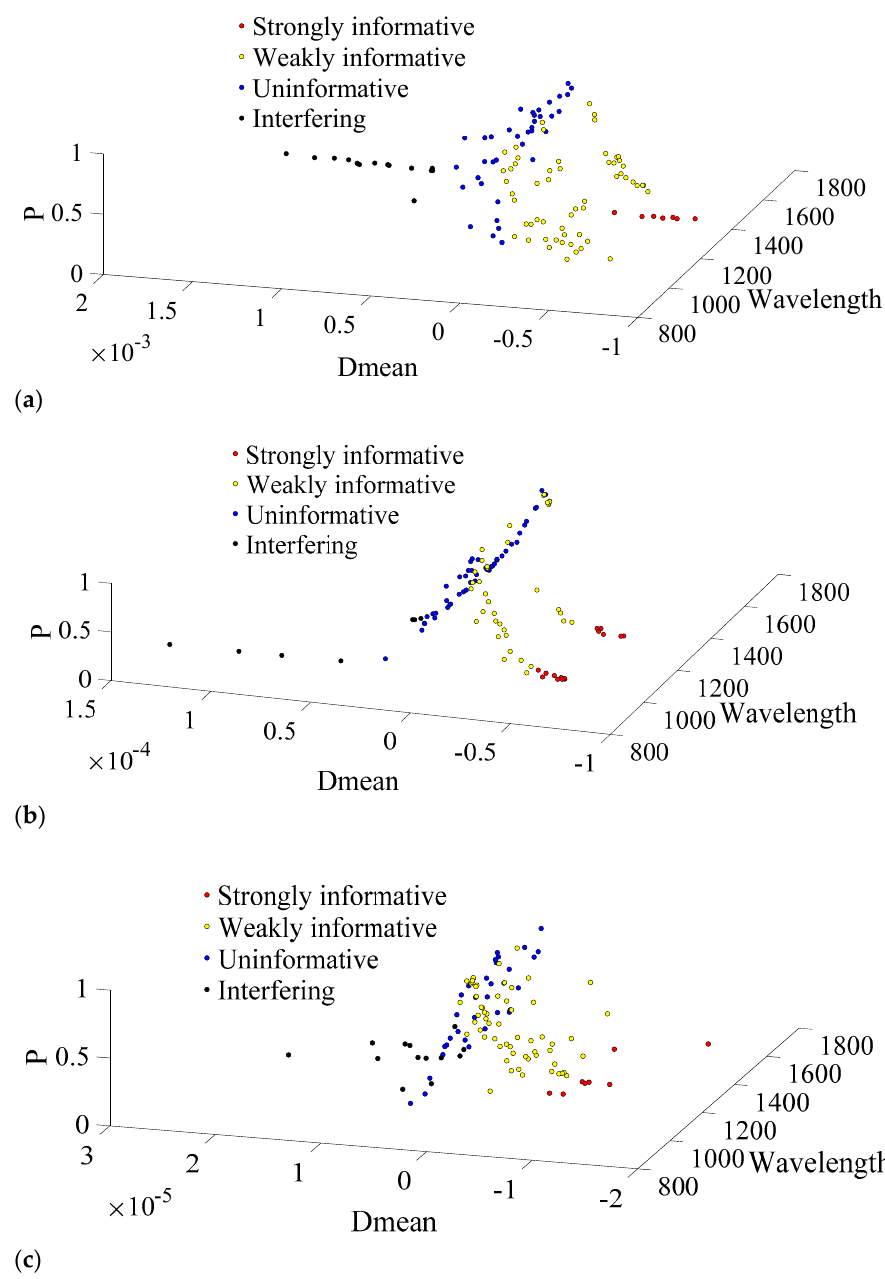
Figure 6. Distribution of wavelengths for different parameters obtained in the second iteration. ( a ) Wavelengths to estimate the a* value. ( b ) Wavelengths to estimate the firmness. ( c ) Wavelengths to estimate the SSC.